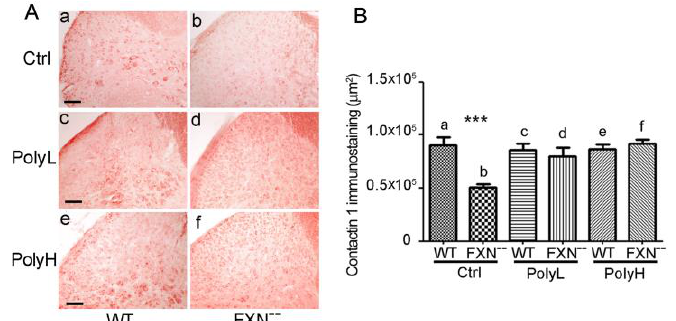
Figure 7. ( A ): Expression of Contactin 1 in the dorsal horn of the spinal cord from either WT (a,c,e) or FXN – mutant (b,d,f) mice in control conditions (Ctrl) (a,b) or in mice undergoing low (PolyL; 0.0185 mg / g, c,d) or high (PolyH; 0.185 mg / g, e,f) dosages of EGCG polyphenol administration in the diet. Scale bar: 50 µ m. ( B ): Morphometric analysis of Contactin 1 immunostaining in the conditions reported in A, expressed as pixels / field. Note the significant reduction of Contactin 1 expression in FXN – mutant mice in control conditions (43%) and its recovery in the presence of polyphenol administration under low (PolyL, c,d) or high (PolyH, e,f) concentration conditions. A p -value < 0.0001, indicated by ***, was considered statistically significant.